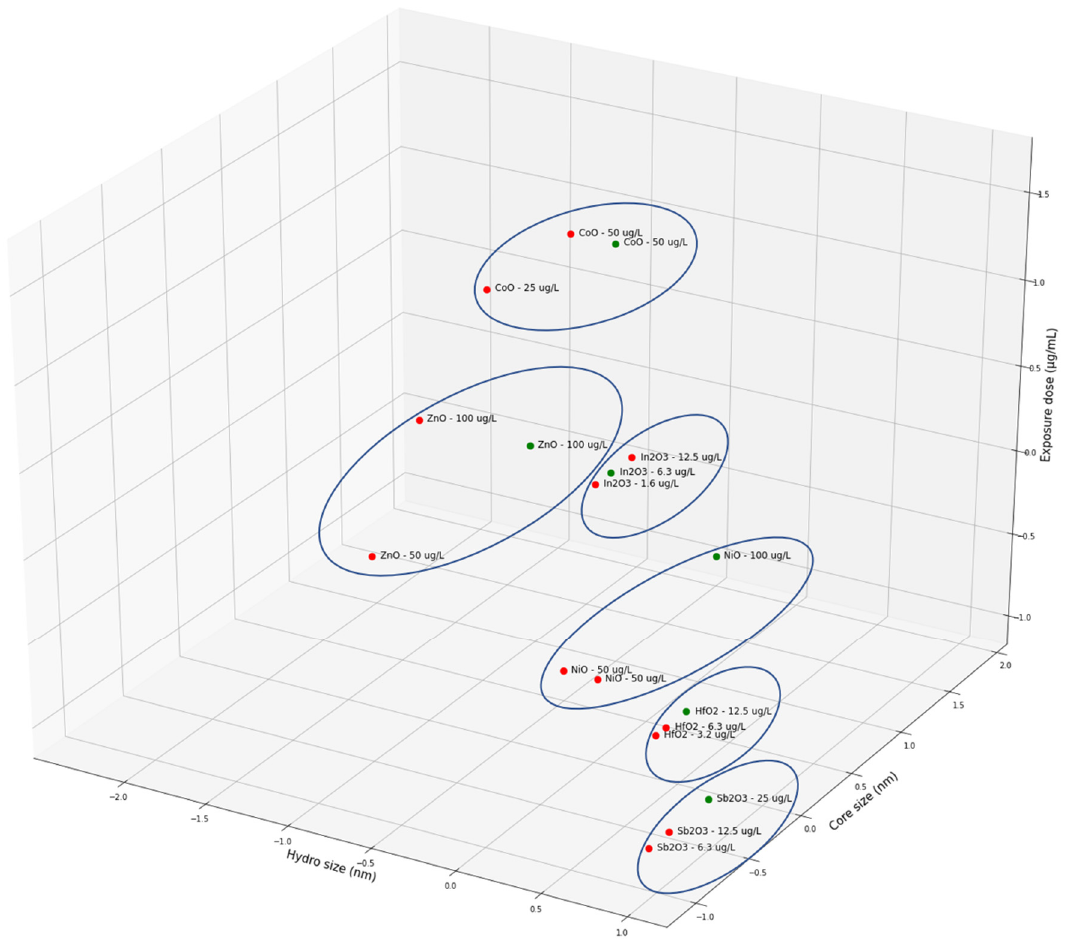
Figure 2. Indicative results for Me x O y (CoO, ZnO, In 2 O 3 , NiO, HfO 2 and Sb 2 O 3 ) NPs from the